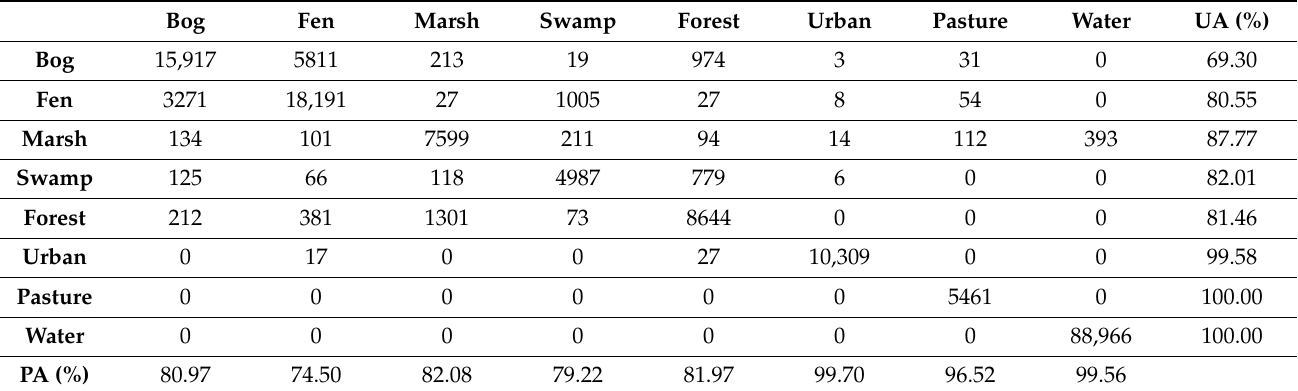
Table 6. Classification confusion matrix of integrating Sentinel-2 and RCM data. An overall accuracy of 91.1% and kappa coefficient of 0.87 were obtained. UA refers to user’s accuracy, while PA refers to producer’s